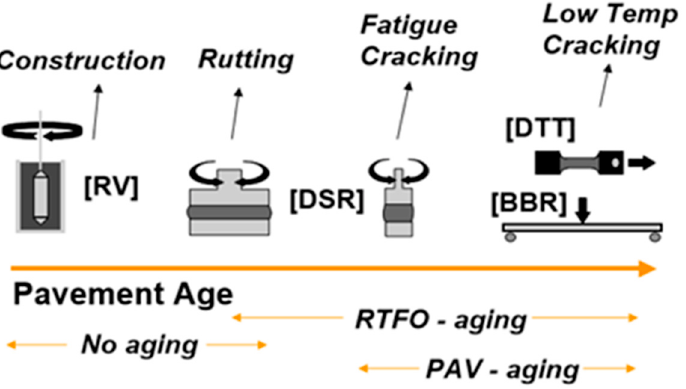
Figure 2. The schematics of rheological investigations of neat and modified bitumen.